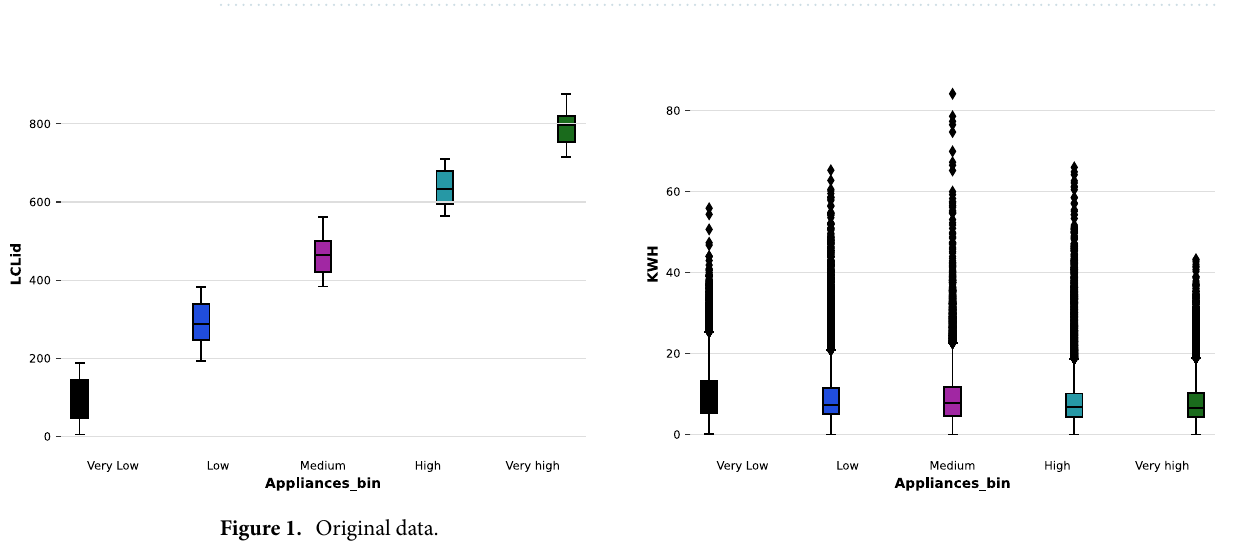
Figure 1. Original